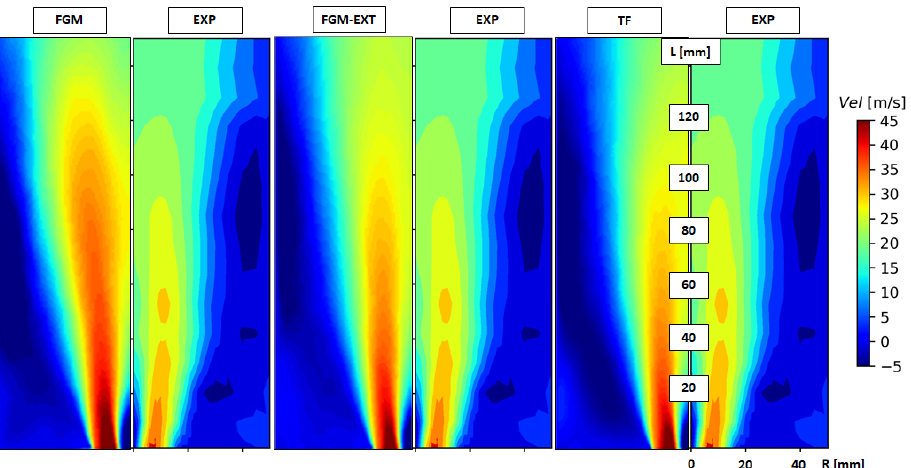
Figure 5. Contour maps of mean axial velocity from FGM, FGM-EXT, and TF (from left to right ) compared with experimental data from